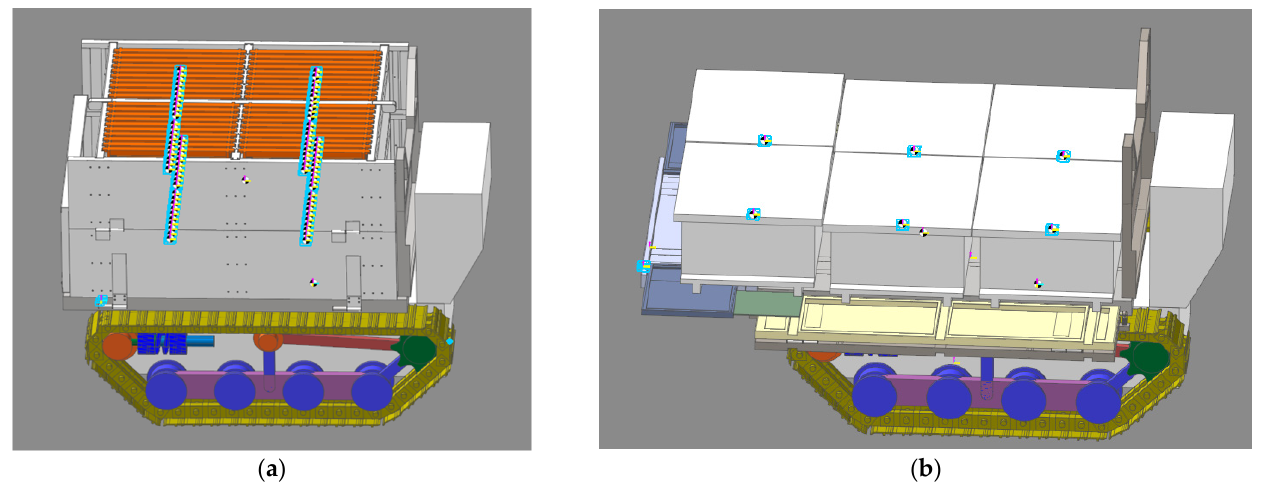
Figure 8. Vehicle dynamics models when the vehicle is fully loaded with ( a ) bee frames and ( b ) beehives.